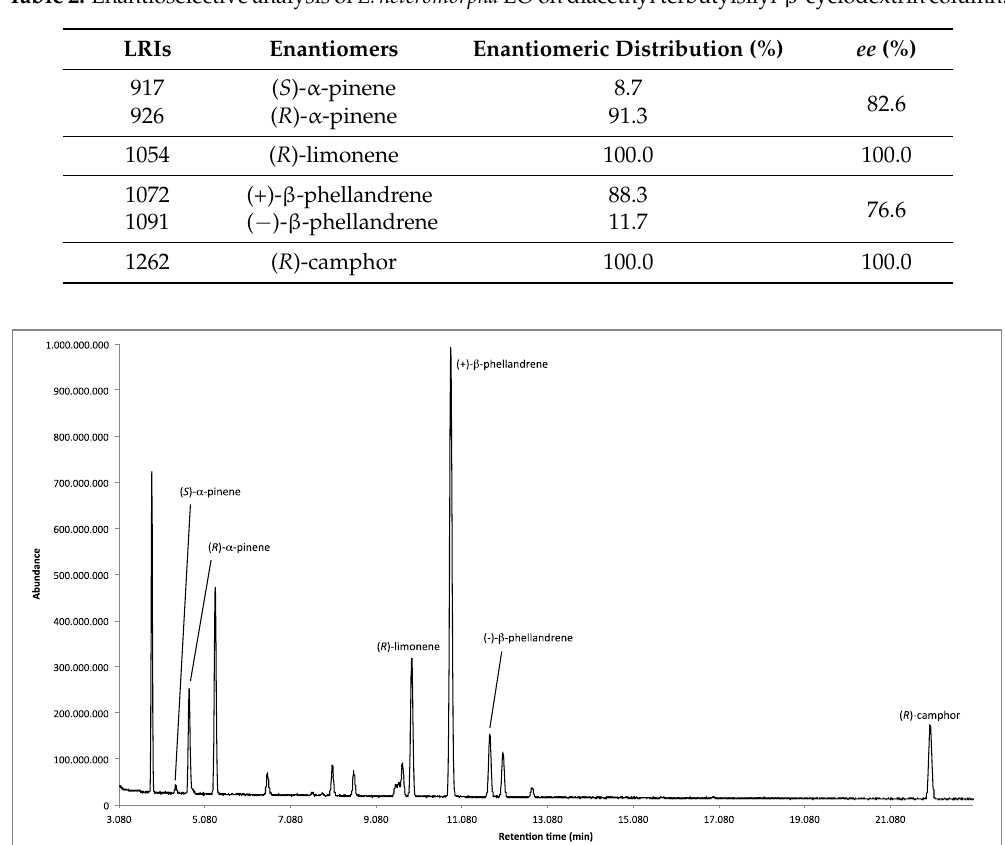
Figure 1. Enantioselective GC pattern of L. heteromorpha EO on diacethyl terbutylsilyl- β -cyclodextrin capillary column. capillary